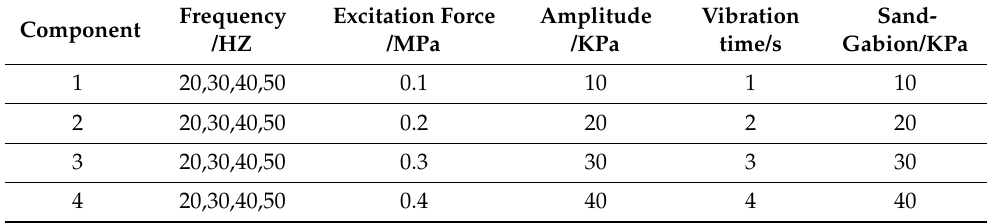
Table 2. Vibration experiment